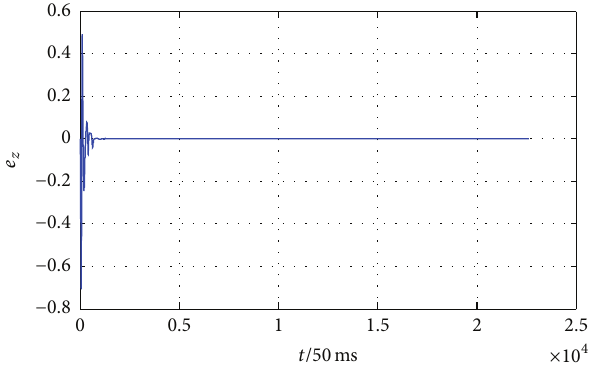
Figure 14: The curve 𝑒 𝑧 for single variable feedback